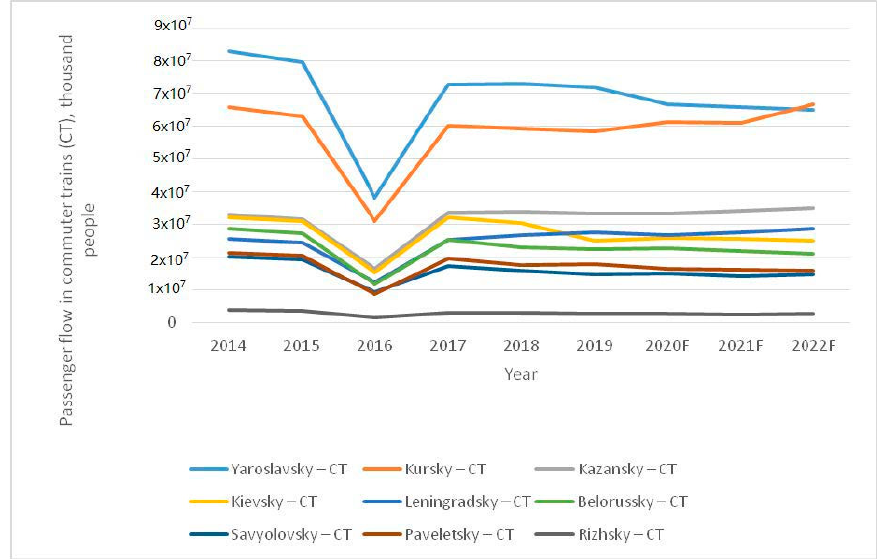
Figure 4. Passenger flow in commuting trains (CT) at Moscow rail stations and its forecast, people.